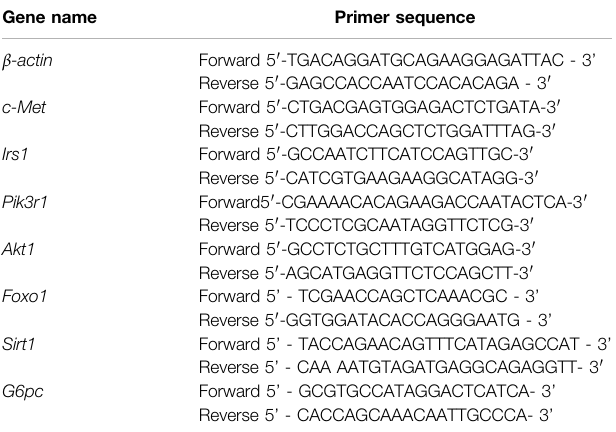
TABLE 1 | The primers used for RT-PCR in this study. Gene